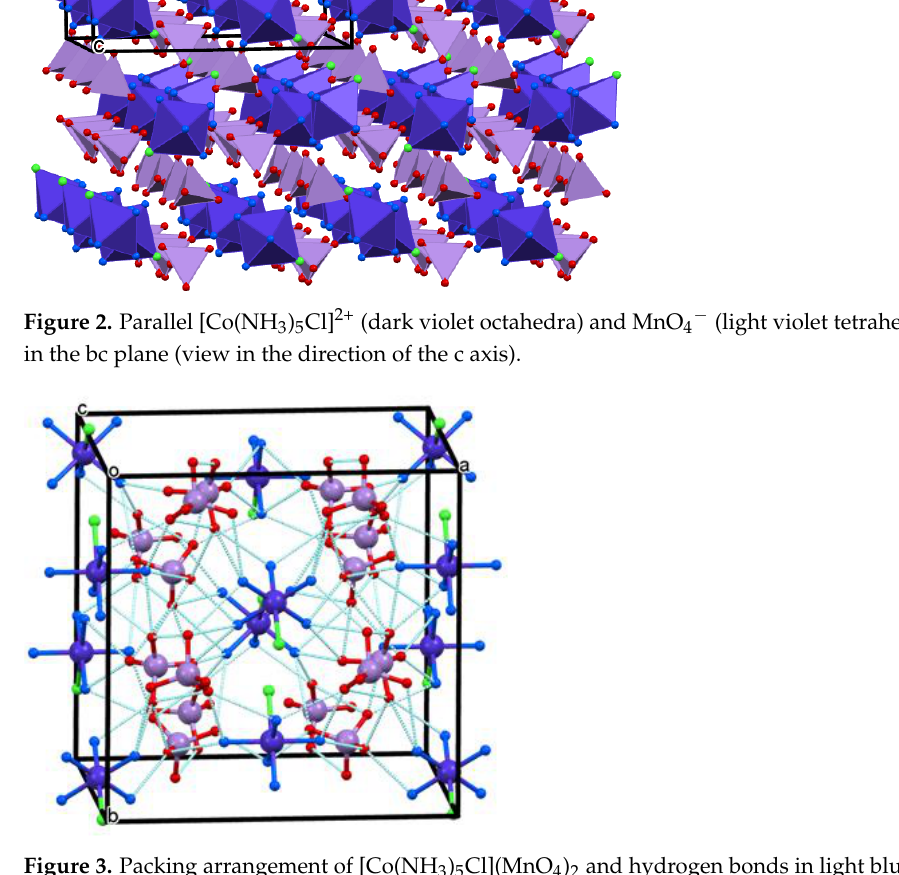
Figure 3. Packing arrangement of [Co(NH 3 ) 5 Cl](MnO 4 ) 2 and hydrogen bonds in light blue (hanging contacts are omitted for clarity) between the ions.